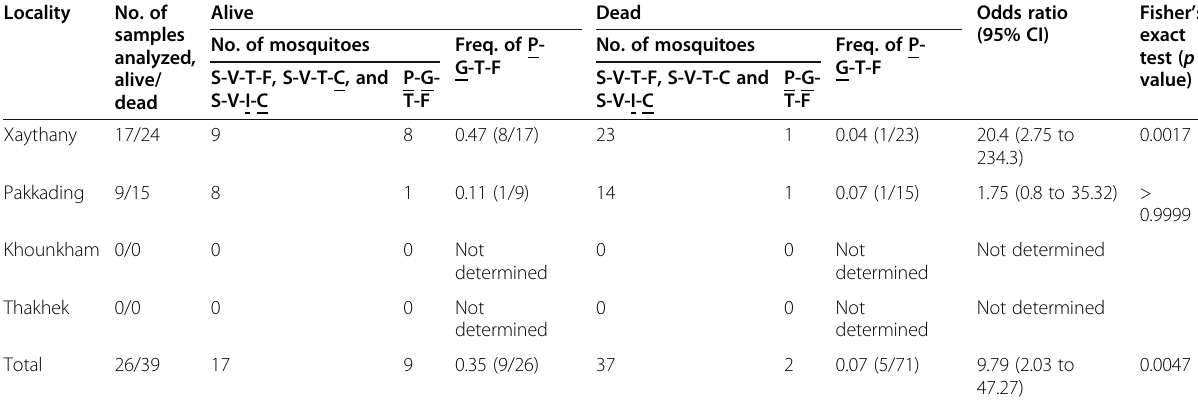
Table 4 Associations between the P-G-T-F haplotype and deltamethrin resistance among Ae. aegypti larvae collected from four populations